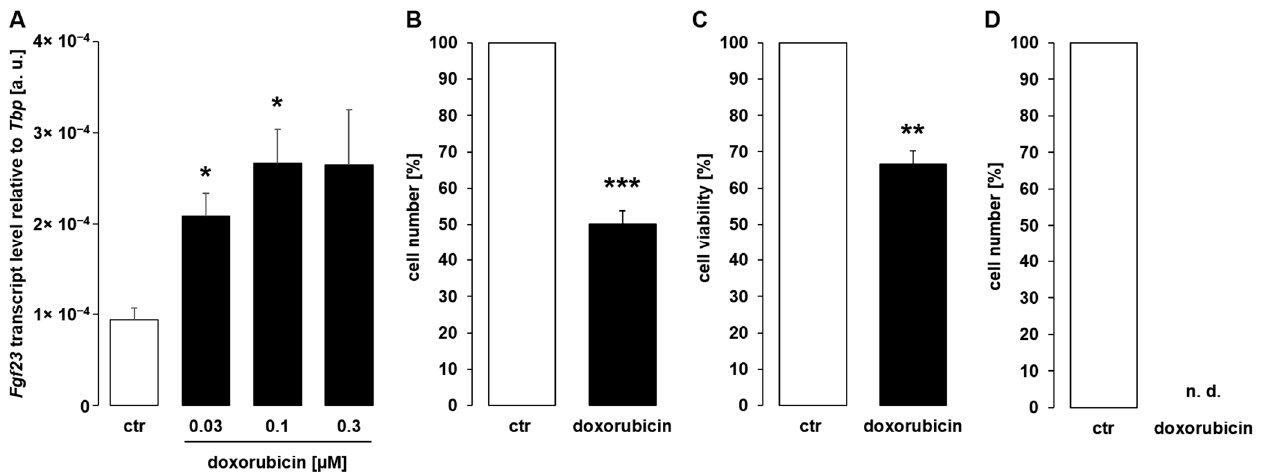
Figure 2. Doxorubicin enhanced Fgf23 expression in UMR106 cells. ( A ): Arithmetic means ± SEM of Fgf23 transcript abundance relative to Tbp in UMR106 cells treated for 24 h with vehicle control (ctr) or doxorubicin at the indicated concentrations ( n = 6; one ‐ way ANOVA followed by Dunnett T3 multiple comparison test). ( B – D ): Arithmetic means ± SEM of the number (( B ); n = 5; one ‐ sample t ‐